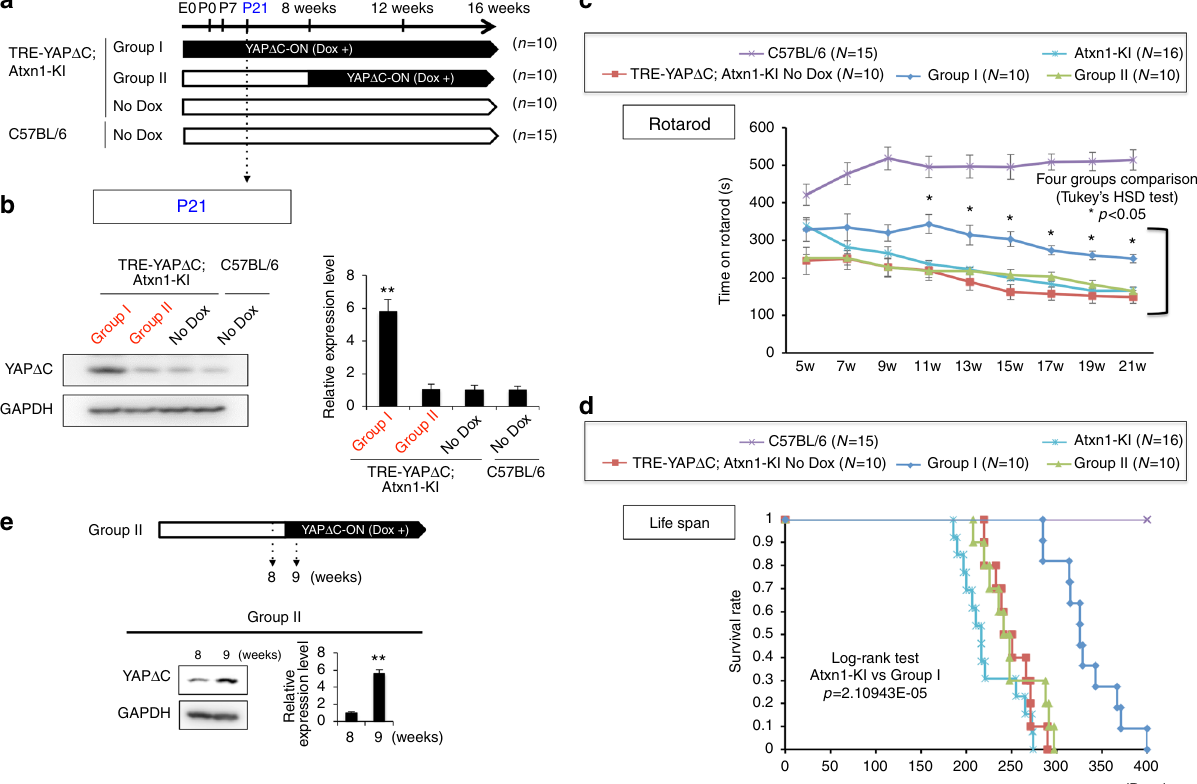
Fig. 1 Experimental design of YAPdeltaC Dox-ON in Atxn1 -KI mice. a Protocol of Dox feeding of the YAPdeltaC Dox-ON mice. The double-transgenic mice (Tet-ON YAPdeltaC; Atxn1 -KI) were divided into three groups (Group I, Group II, No Dox) following the Dox administration/feeding protocol as indicated. b Protein levels of YAPdeltaC in the cerebellum of Group I mice at P21 were examined by western blot. The blot was re-probed with GAPDH antibodies. Double asterisks indicate statistical signi fi cance ( p < 0.01, N = 6) in one-way ANOVA with post hoc Tukey ’ s HSD test. c Temporal changes in motor function in fi ve groups of mice, as determined by the Rotarod test. Asterisks indicate signi fi cant differences vs. Atxn1 -KI mice in the multiple group comparison (one-way ANOVA with post hoc Tukey ’ s HSD test, p < 0.05). d Survival ratio of fi ve groups. Log-rank test con fi rmed the signi fi cance of the lifespan elongation in Group I. e Effect of Dox-ON at 8 weeks of age on YAPdeltaC protein expression at 9 weeks of age, evaluated by western blot with YAPdeltaC antibody. Double asterisks indicate statistical signi fi cance ( p < 0.01, N = 6) in Student ’ s t